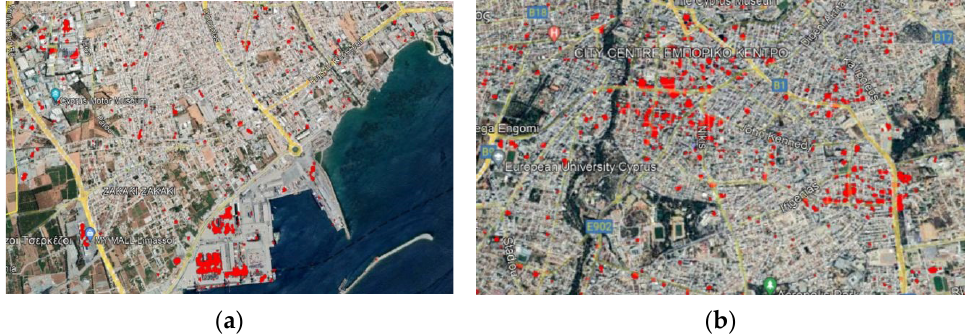
Figure 11. Changes tracked in SAR images visualized on Google Earth: ( a ) Limassol; ( b ) Nicosia.